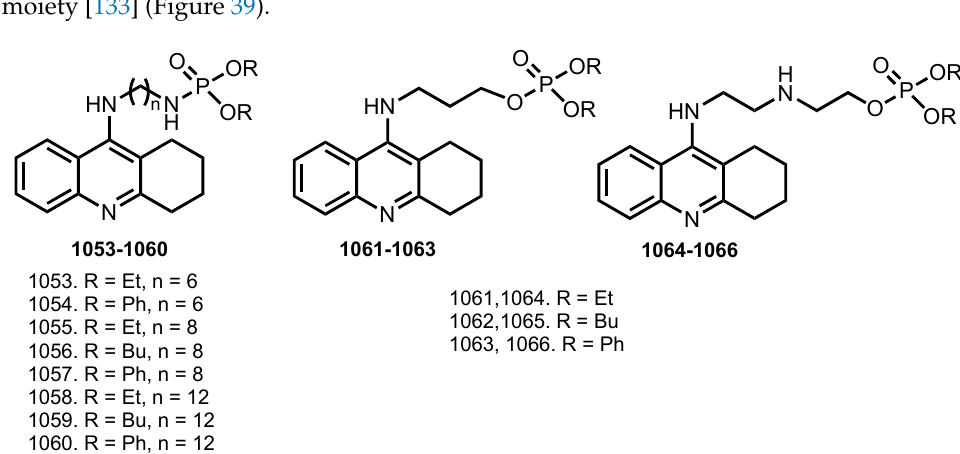
Figure 39. THA hybrids with phosphorus moieties 1053 – 1066 [133].